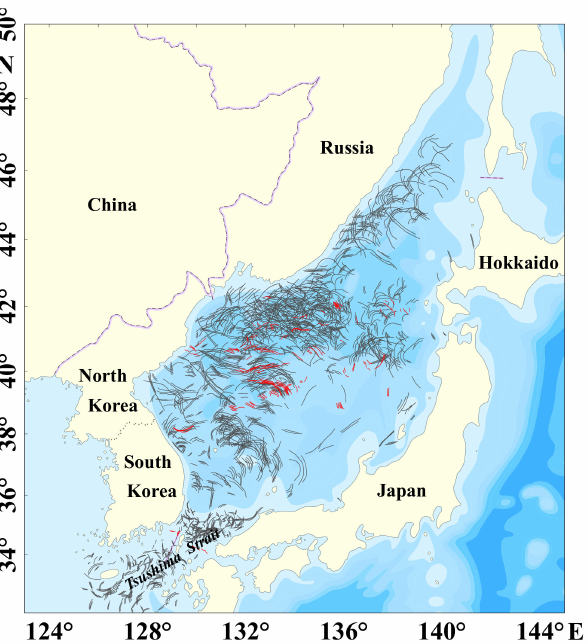
Figure 4. Map of the spatial distribution characteristics of ISW crest lines in the Sea of Japan. The gray solid lines are the MODIS image extraction results, while the red solid lines are the InIRA image extraction